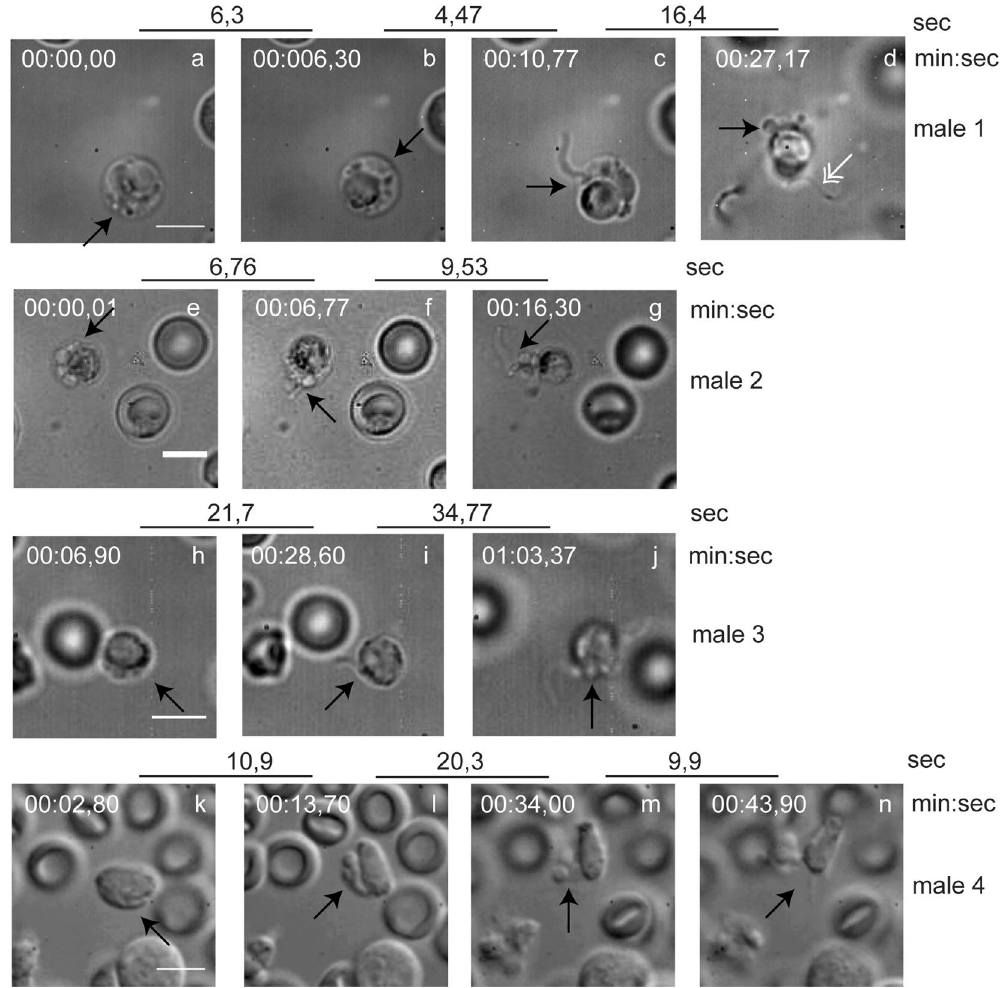
Figure 2. Snapshots from movies of four male gametocytes undergoing egress and exflagellation. Representative snapshots chosen to illustrate the stages of egress. Upper broken lines represent time in sec between each frame of the movies in real time. The time of each frame from the start of the movies is indicated above the snapshots (min:sec). For technical reasons this does not correspond with the time from the start of the experiment (activation). ( a – d ) Male 1. ( a , b ) The RBC is swollen with PVM vesicles visible. ( c ) A flagellum is exiting the RBCM through a single pore. ( d ) Egress is complete. Vesiculated PVM and RBCM are localized in proximity residual gametocyte and a free flagellum is also visible (white double arrow). ( e – g ) Male 2. ( e ) The PVM is already vesiculated inside the RBCM. ( f ) A vesicle exits the RBCM through a single pore followed by a single flagellum. ( g ) Egress is complete with vesicles and a free flagellum next to the residual gametocyte. ( h – j ) Male 3. ( h ) The RBCM is extended with PVM vesicles inside. ( i ) A single flagellum is exiting the RBCM through a single pore. ( j ) Egress is complete, with vesicles and one flagellum in proximity to the residual gametocytes. ( k – n ) Male 4. ( k ) The RBCM is extended. ( l ) The PVM is vesiculated. ( m ) Vesicles of RBCM and PVM are seen close to the cell. ( n ) Exflagellation complete. Black arrows indicate the area of interest in each snapshot. Scale bar, 5 μ m. See also Supplementary Information Videos